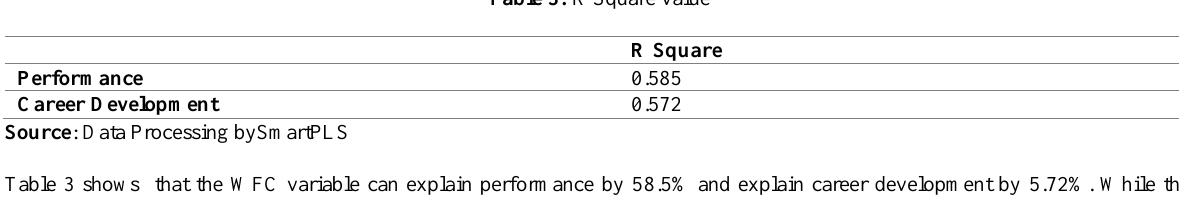
Table 3: R Square value